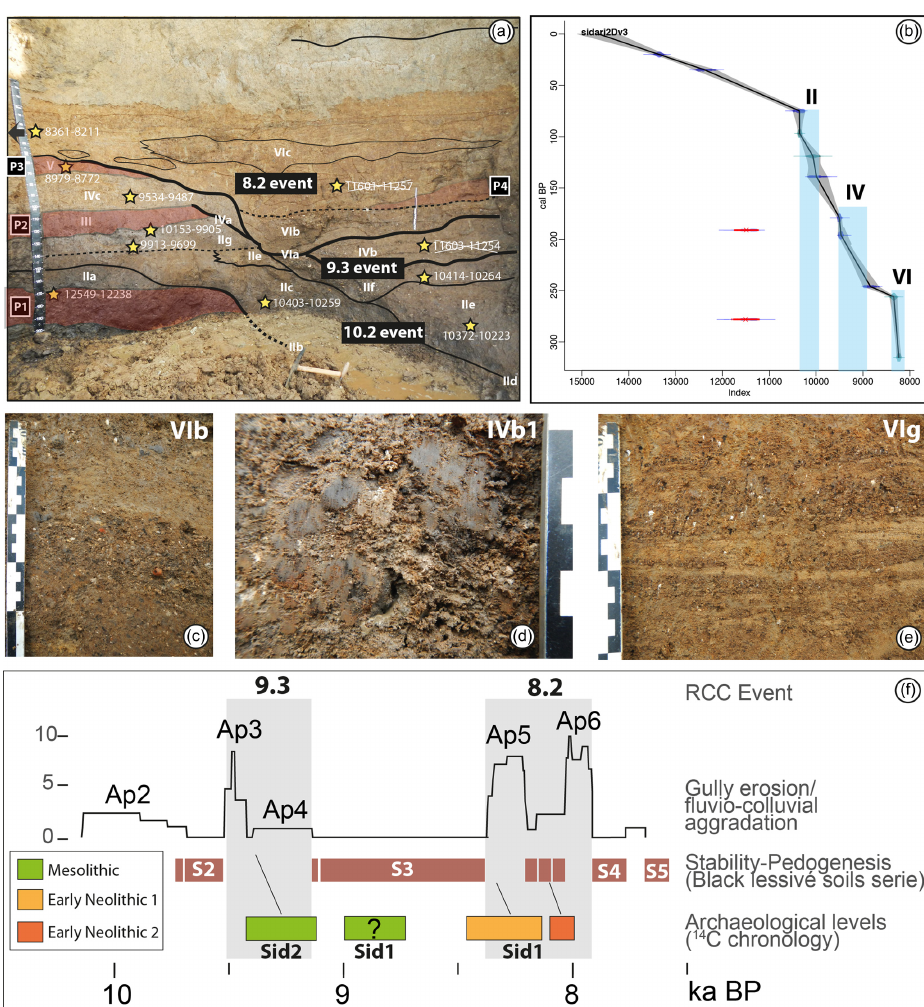
Figure 11. (a) Middle–lower pedosedimentary sequence of Sidari 2 with early Holocene palaeosols (P1–P4), aggradation and gully phases (IIa–VIc). Yellow stars: AMS radiocarbon dates. (b) Stairway age–depth model with three phases of high acceleration of sedimentation rate (phase II: 10.4–9.9; phase IV: 9.5–8.9; and phase VI: 8.4–8.1ka). (c) Field photo of gravel and sand filling of the 9.2ka event